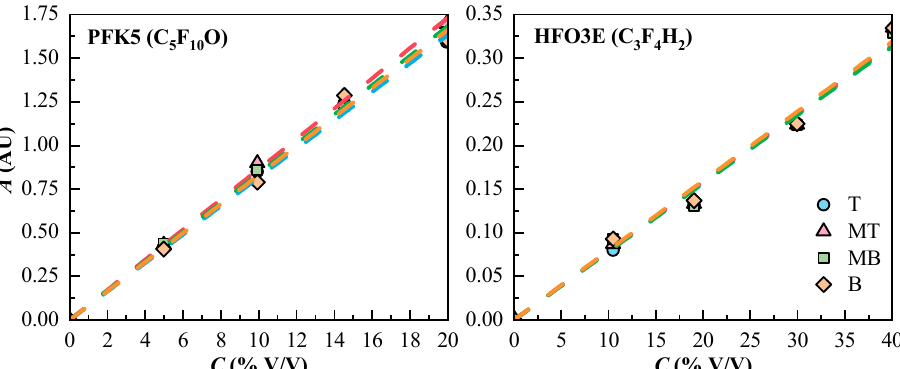
Figure 3. Experimental concentration values ( C exp , dots) and calibration curves (dashed lines) of the components of the gas mixtures. T (Top, ), MT (Medium Top, ), MB (Medium Bottom, ), and B (Bottom, ) correspond to the different heights of the measurement lines. Table 4. Linear regression equations, correlation coefficients ( r 2 ), and molar absorptivities ( ε M ), of PFK5 and HFO3E.